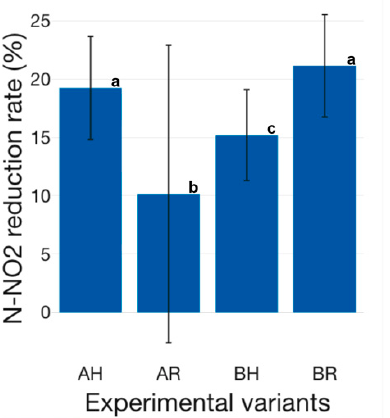
Figure 26. The N-NO 2 reduction rate and SE for each of the experimental variants (Tukey test)—